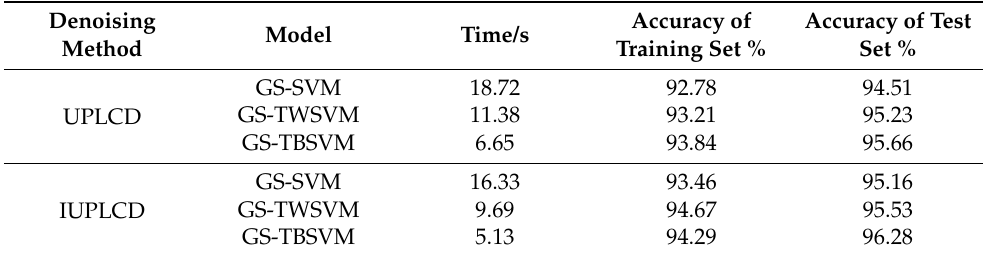
Table 1. Performance comparison of different methods.